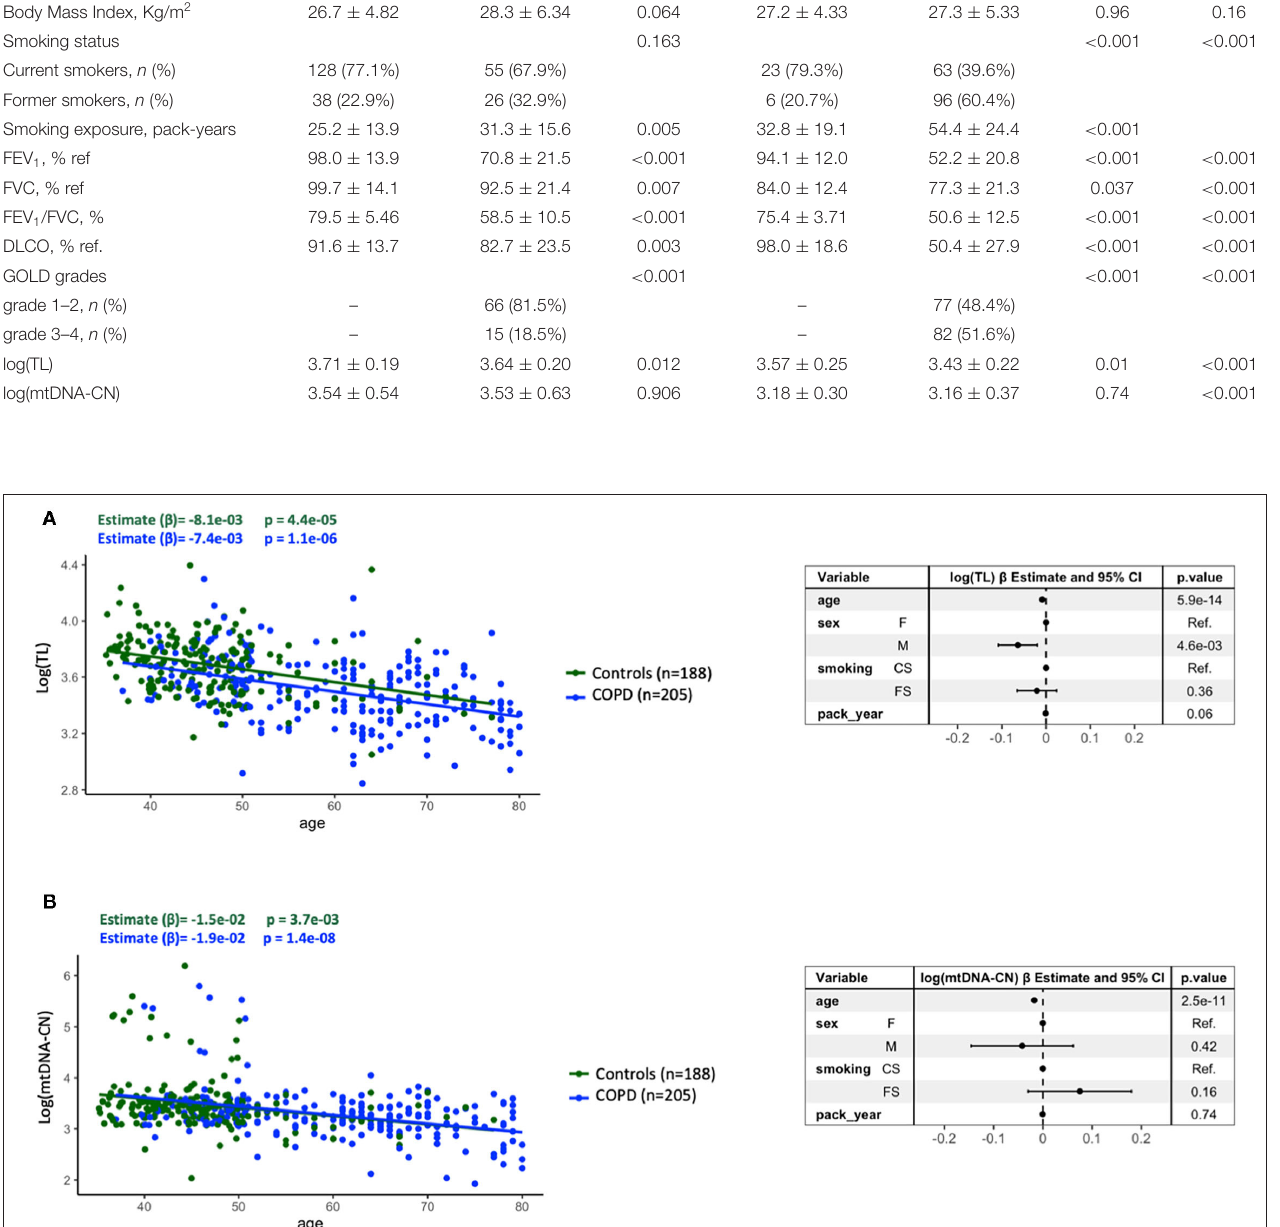
Frontiers in Medicine |